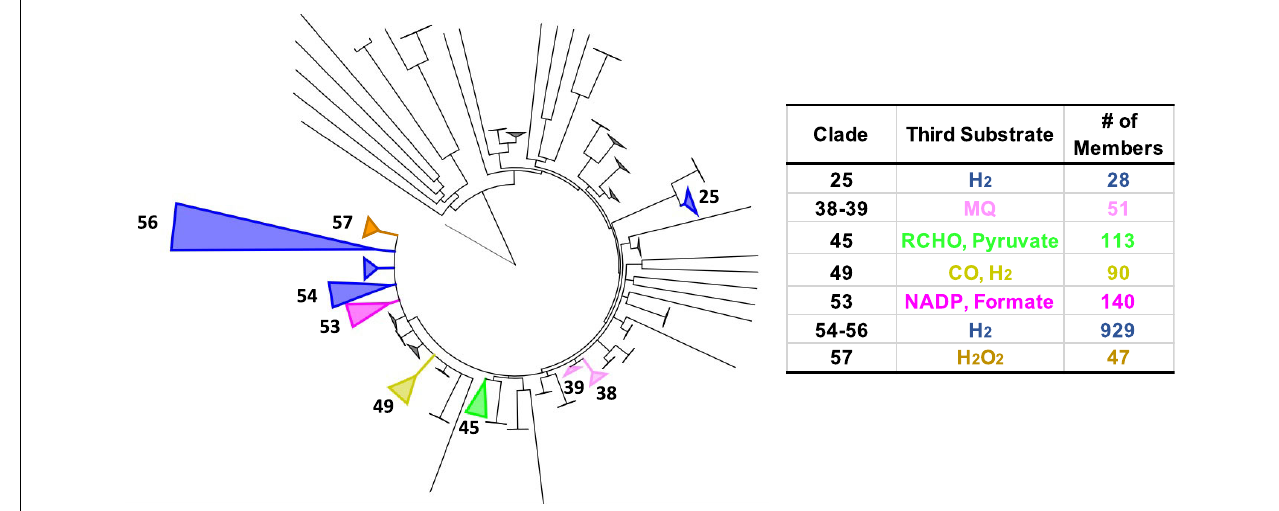
FIGURE 2 | Phylogenetic tree of Bfu enzymes based on BfuB and distribution of characterized and predicted functions as defined by the third substrate. Left: tree based on 1558 BfuB homologs (containing InterPro domains IPR011538, IPR019554, IPR019575, and IPR017896). BfuB clades were defined as having a branch root length of < 0.33 to minimize the number of clades while highlighting functional differences, leading to 57 total clades (23 orphan clades). Clades with predicted functions are numbered. Right: number (#) of different enzymes in each clade classified by the third substrate utilized [in addition to Fd and NAD(H)]. Clade sizes are proportional to the number of members. The non-bifurcating BfuB homolog Nqo1 from Thermus thermophilus was used as the